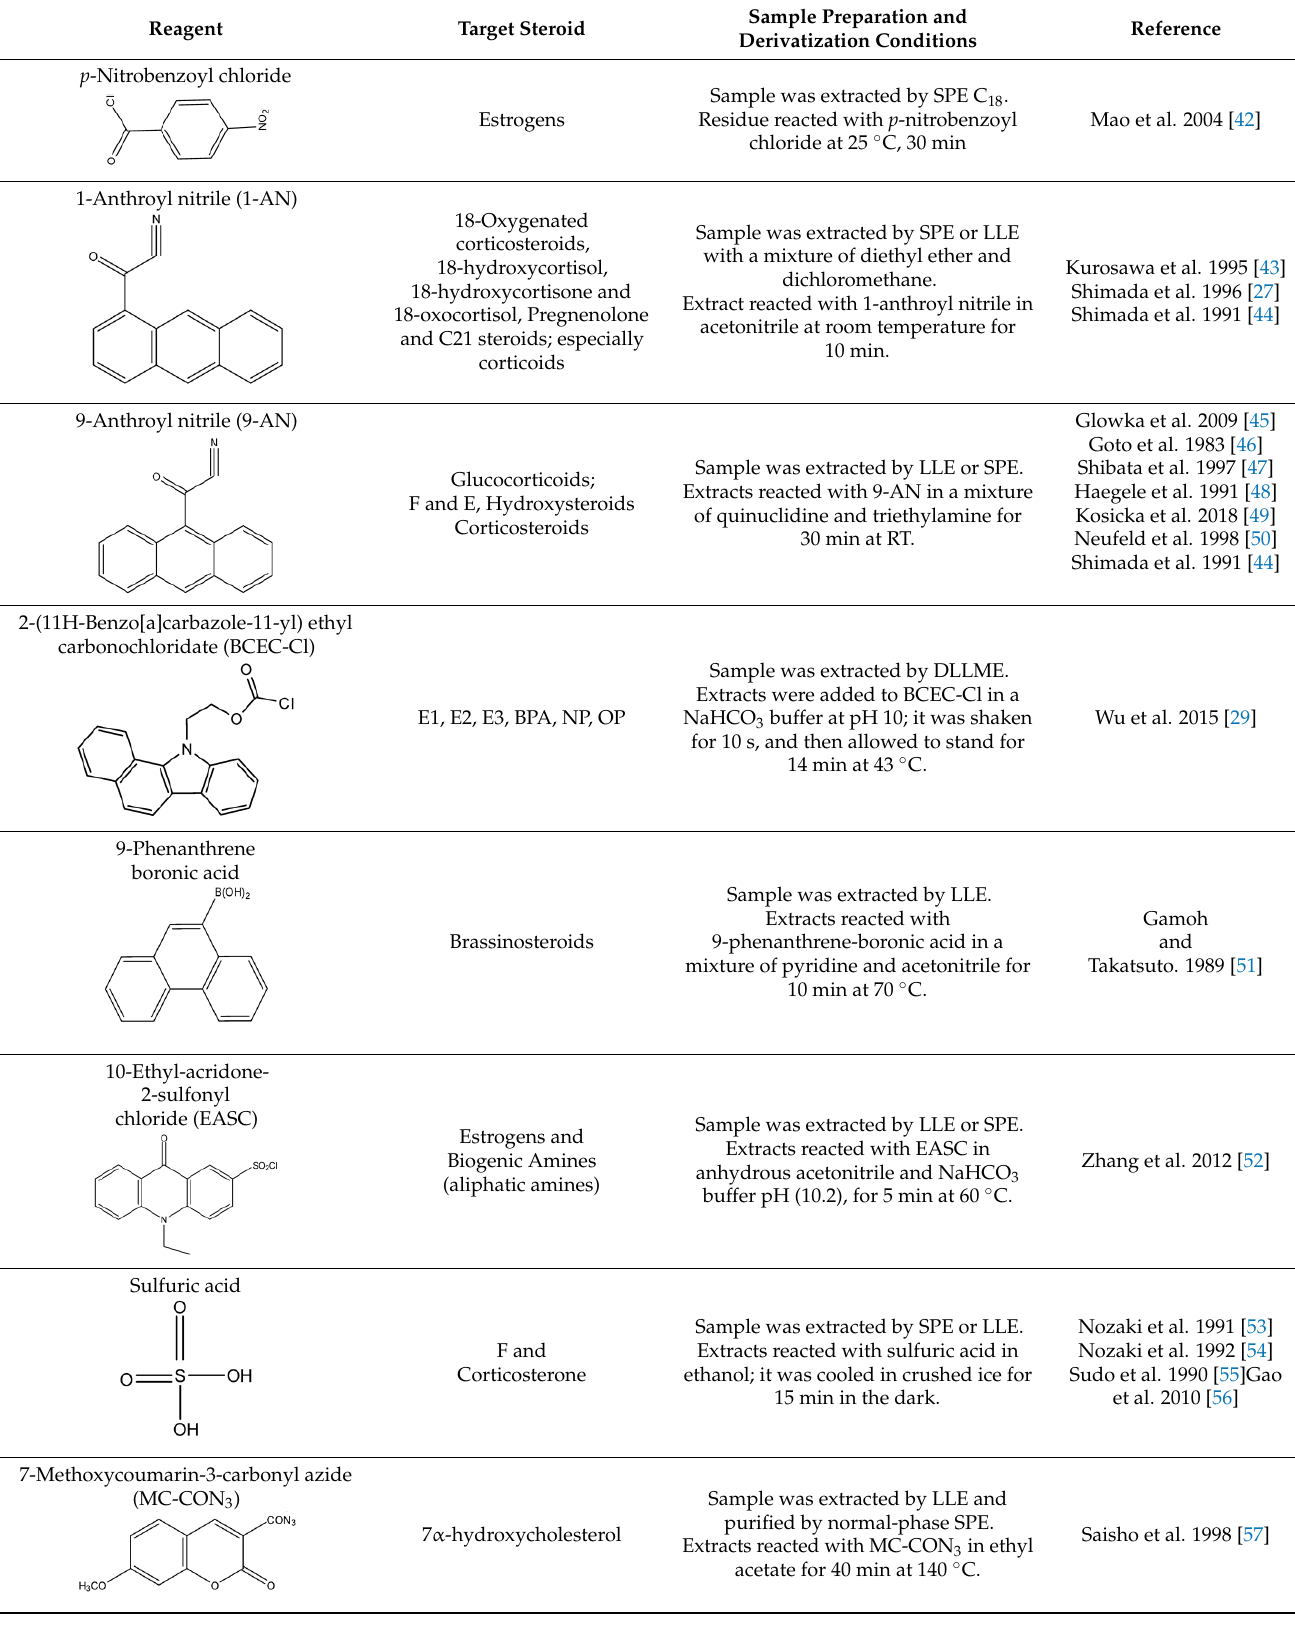
Table 1. Derivatization reagents and conditions used in steroid quantification by HPLC-FLD.